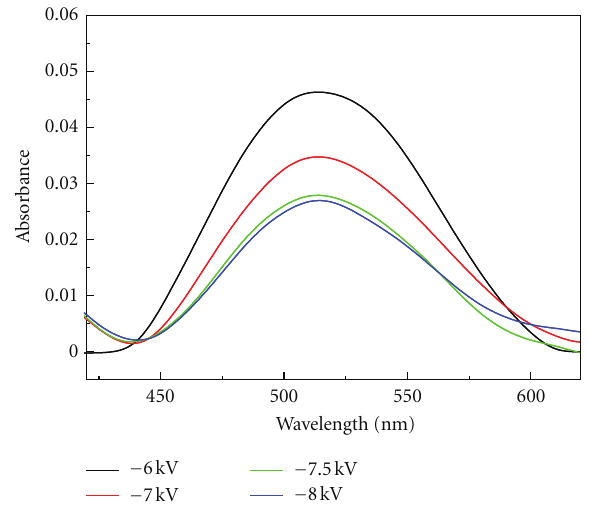
F 4: Effect of poling conditions on the order parameter ( DR1/ -CDP complex. 𝛾𝛾